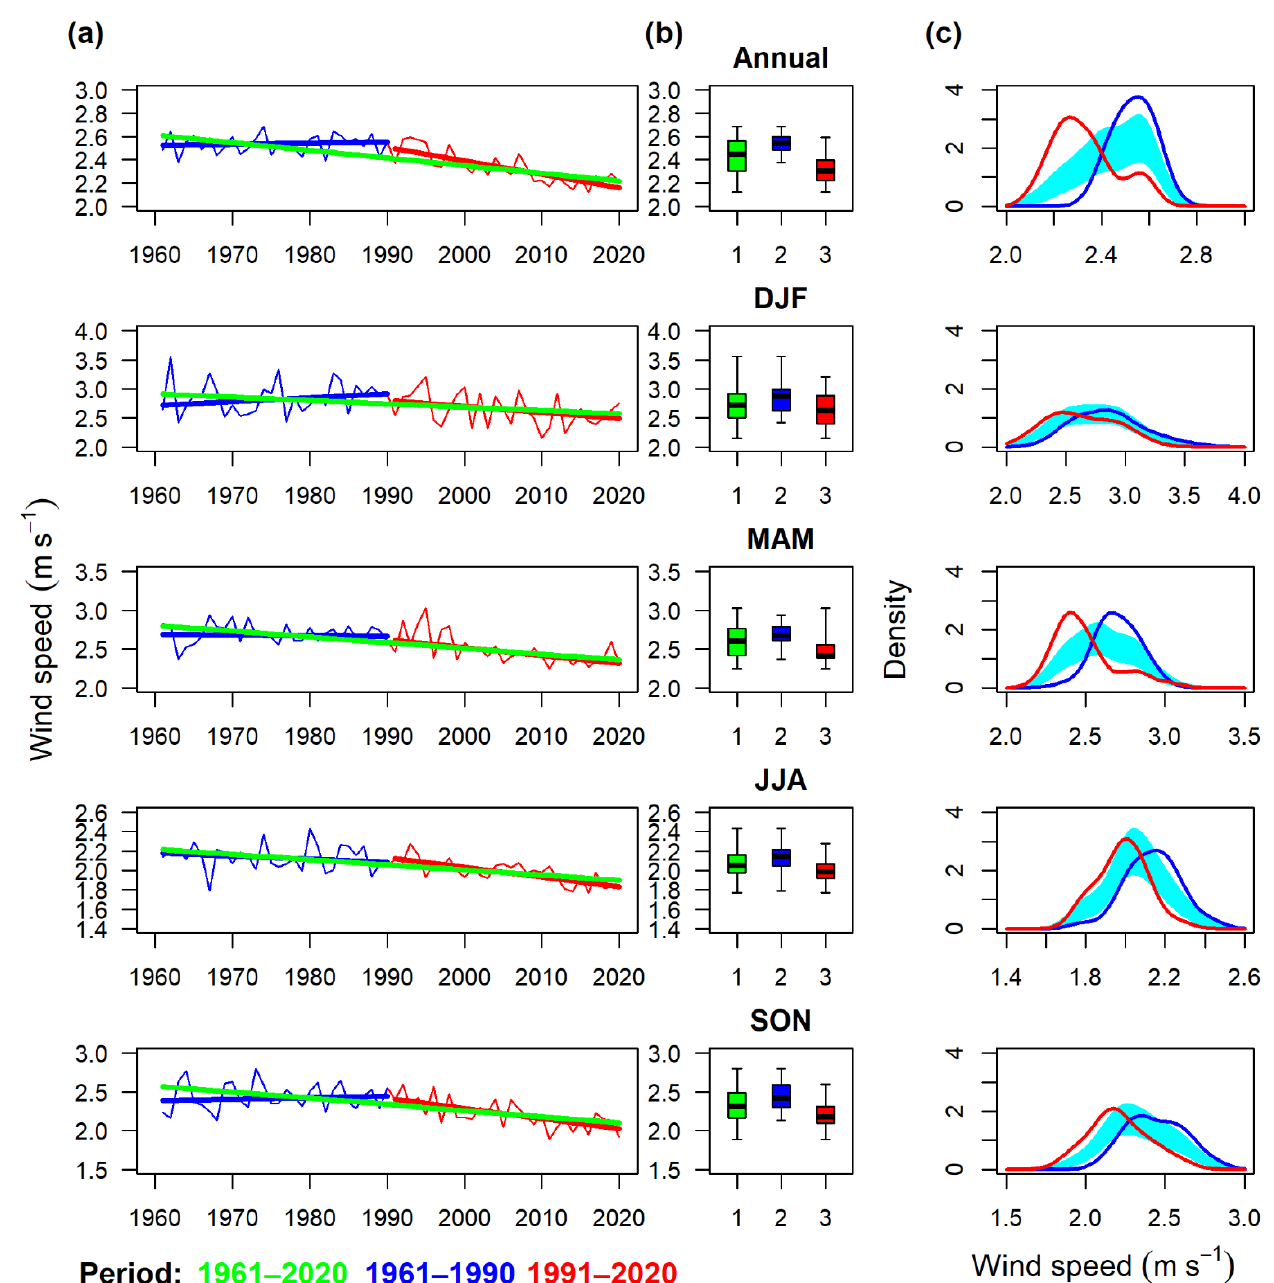
Figure 11. Annual and seasonal series of mean wind speed for the territory of the Czech Republic in the 1961 – 2020 period: ( a ) fluctuations with linear trends in the entire period, 1961 – 1990 and 1991 – 2020; ( b ) box plots (median, lower and upper quartile, minimum, and maximum) for 1961 – 2020 (1), 1961 – 1990 (2) and 1991 – 2020 (3); ( c ) the density distribution of the series in 1961 – 1990 and 1991 – 2020. The density curves outside the reference band (green – blue) indicate a significant difference in the two distributions (and vice versa).